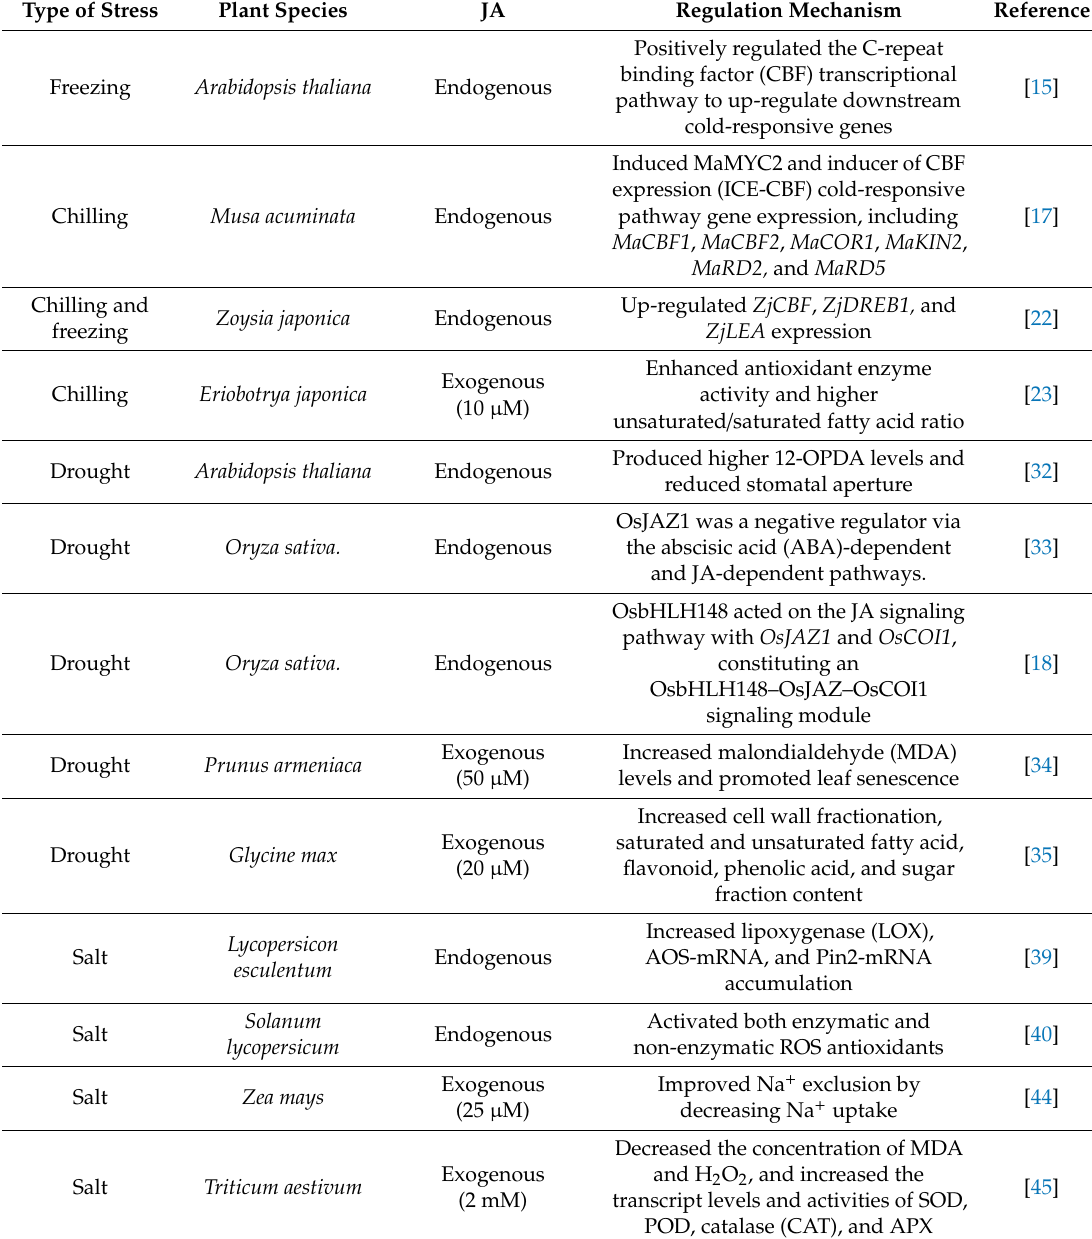
Table 1. Regulation mechanism of endogenous and exogenous JAs in response to abiotic stress in